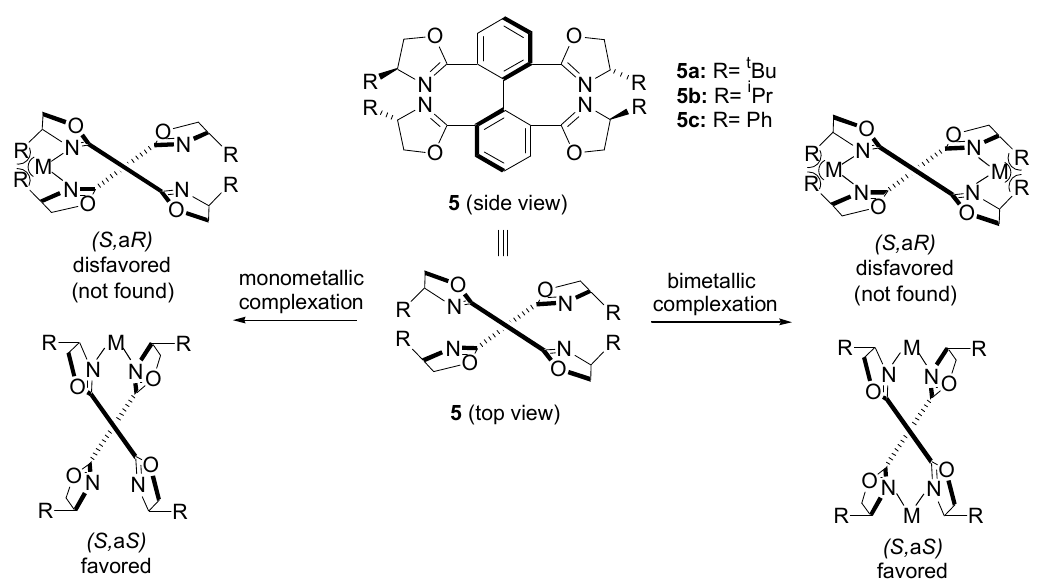
Figure 1. Model figures of diastereomeric monometallic and bimetallic complexes with tetraoxazoline